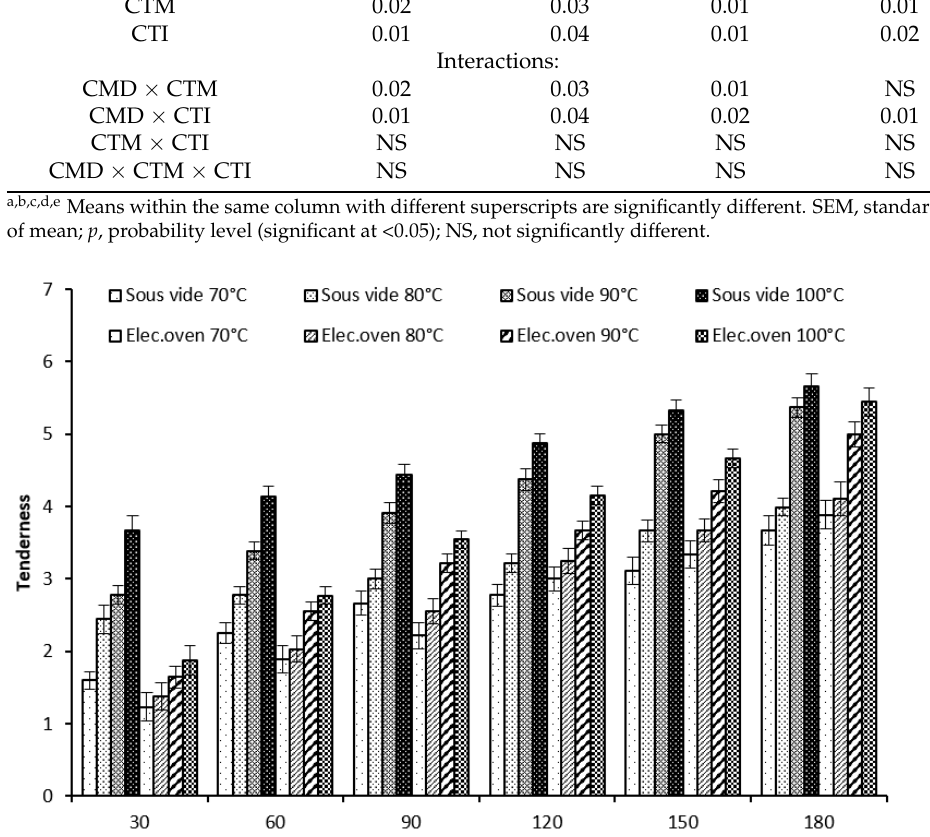
Figure 9. The effect of the cooking method (sous vide vs electrical oven) on the camel meat sensory properties (flavor) at different combinations of temperature and time.